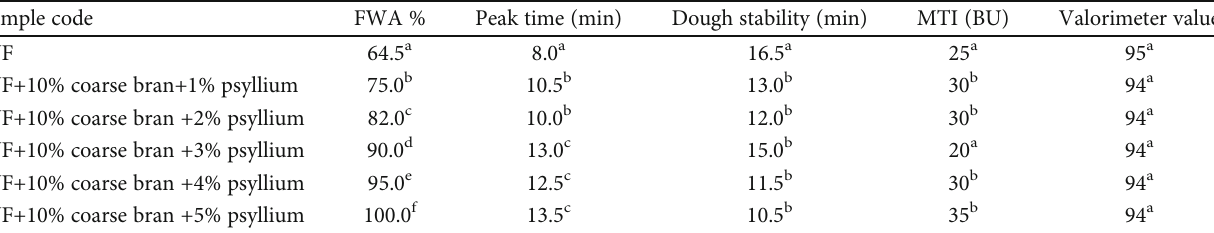
Table 5: Farinograph characteristics of dough made from fl our, coarse bran, and psyllium